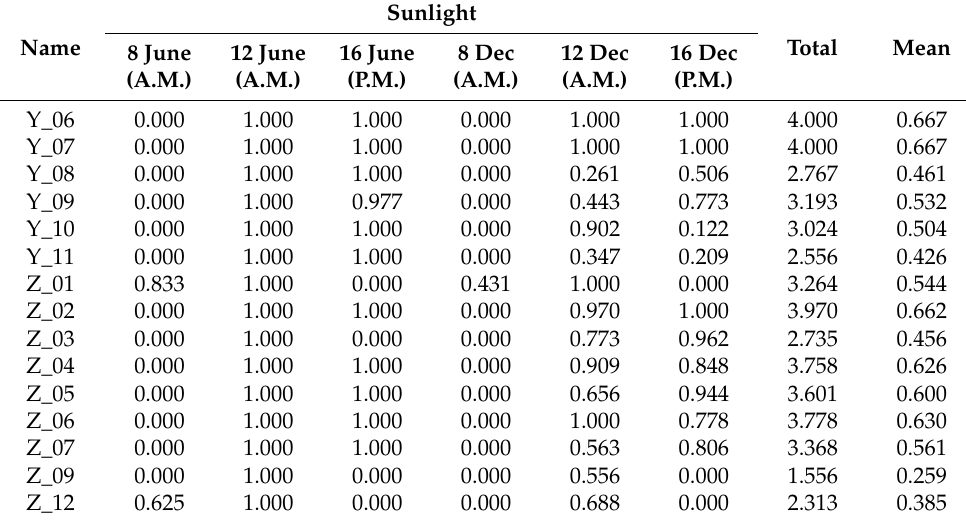
Table 6. The results of sunlight analysis.